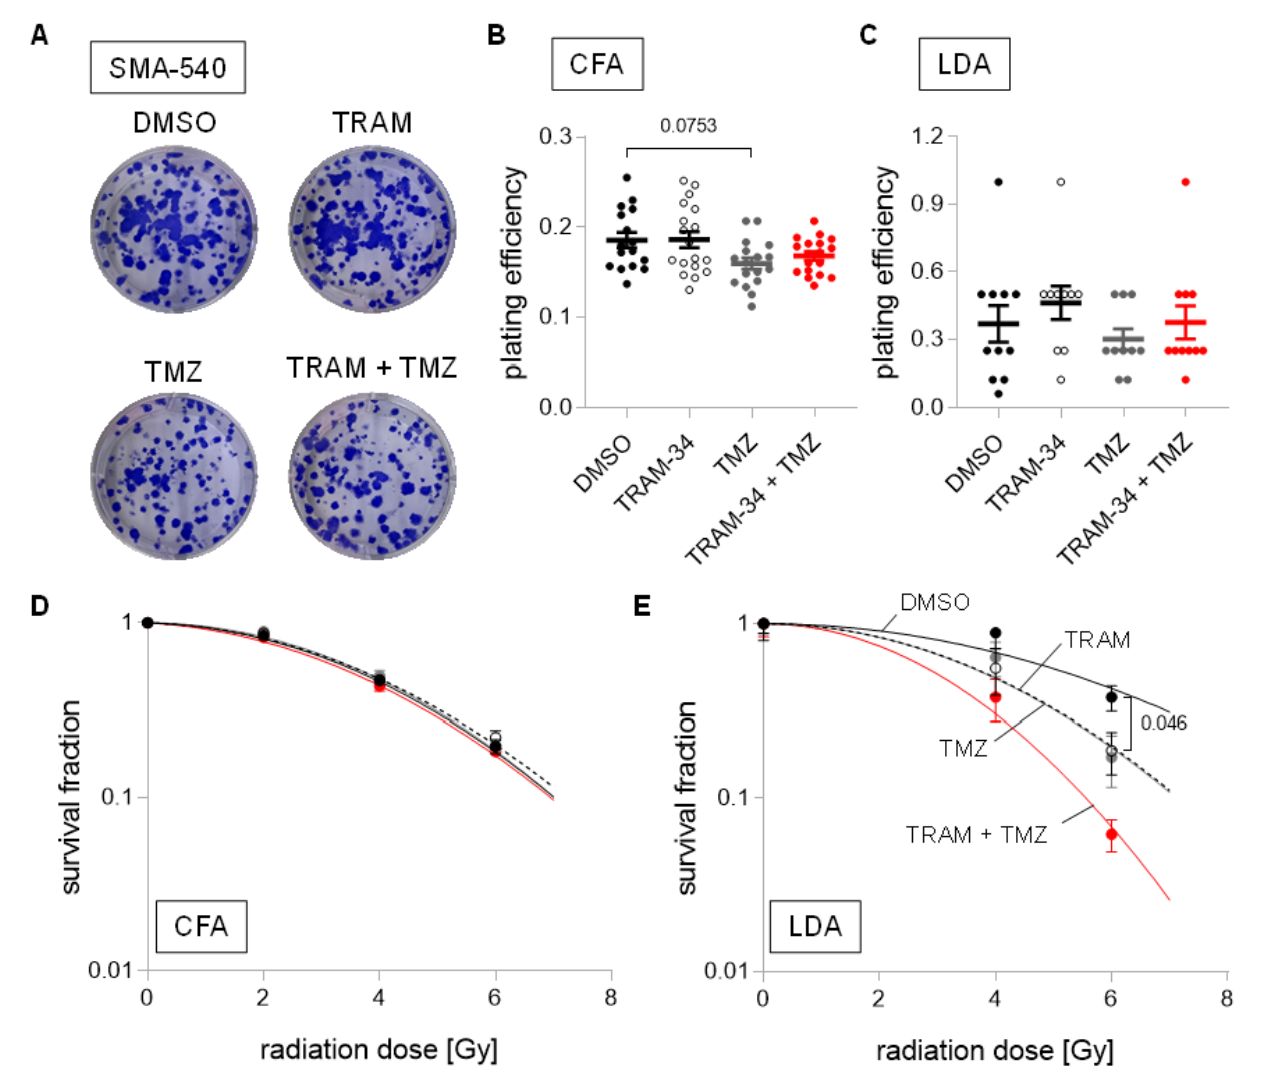
Figure 6. Cell culture condition-dependent effects of K Ca 3.1 blockade on sensitivity to irradiation and temozolomide in SMA-540 cells. ( A – C ). Representative images of colony formation ( A ) and plating efficiencies ( B ) of DMEM-grown or ( C ) NSC-grown cells after irradiation with 0 Gy and co-treatment with vehicle (DMSO, closed black circles), TRAM-34 (5 µ M, open circles), temozolomide (TMZ, 30 µ M, closed grey circles), or TRAM-34 (5 µ M) together with temozolomide (TMZ, 30 µ M, closed red circles). ( D , E ). Survival fractions of irradiated (0–6 Gy) cells co-treated with vehicle (DMSO, closed black circles), TRAM-34 (5 µ M, open circles), temozolomide (TMZ, 30 µ M, closed grey circles), or TRAM-34 (5 µ M) together with temozolomide (TMZ, 30 µ M, closed red circles) as determined by colony formation assay for DMEM-grown ( D ) and limited dilution assay for NSC-grown SMA-540 cells ( E ). Data are individual values in ( B , C ) and mean ± standard error in ( B – E ) of three experimental units with four to six observational units each. Survival fraction curves were fitted according to the linear quadratic model and given as follows: DMSO, solid black line; TRAM-34, dashed line; temozolomide, solid grey line; TRAM-34 and TMZ, solid red line. Numbers in ( B , E ) indicate error probabilities ( p values) as calculated with one-way ANOVA and Tukey multiple comparison